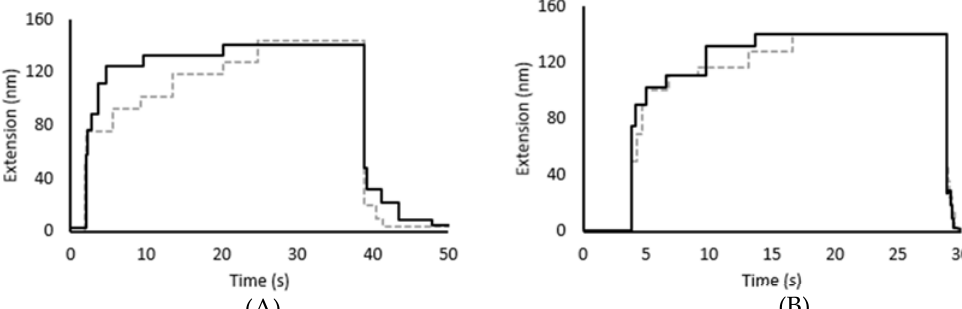
Figure 3. Sample unfolding plots from magnetic tweezers exhibit slower unfolding rates in presence of calcium. ( A ) Un- folding steps at 40 pN occurred more rapidly in the absence of calcium (black) than in the presence of calcium (dashed gray). ( B ) Unfolding steps at 50 pN occurred slightly more rapidly in the absence of calcium (black) than in the presence of calcium (dashed gray). The first unfolding step is not visible when unfolding at 50 pN because it occurs during the elastic extension step.